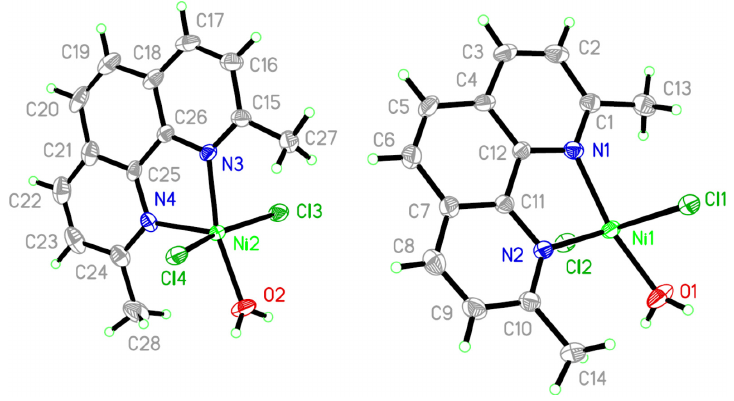
Figure 6. ORTEP (Oak Ridge Thermal Ellipsoid Plot) plot of two molecular units per asymmetric unit in P-1 showing atom labelling. Thermal ellipsoids are drawn at the 50% probability level.